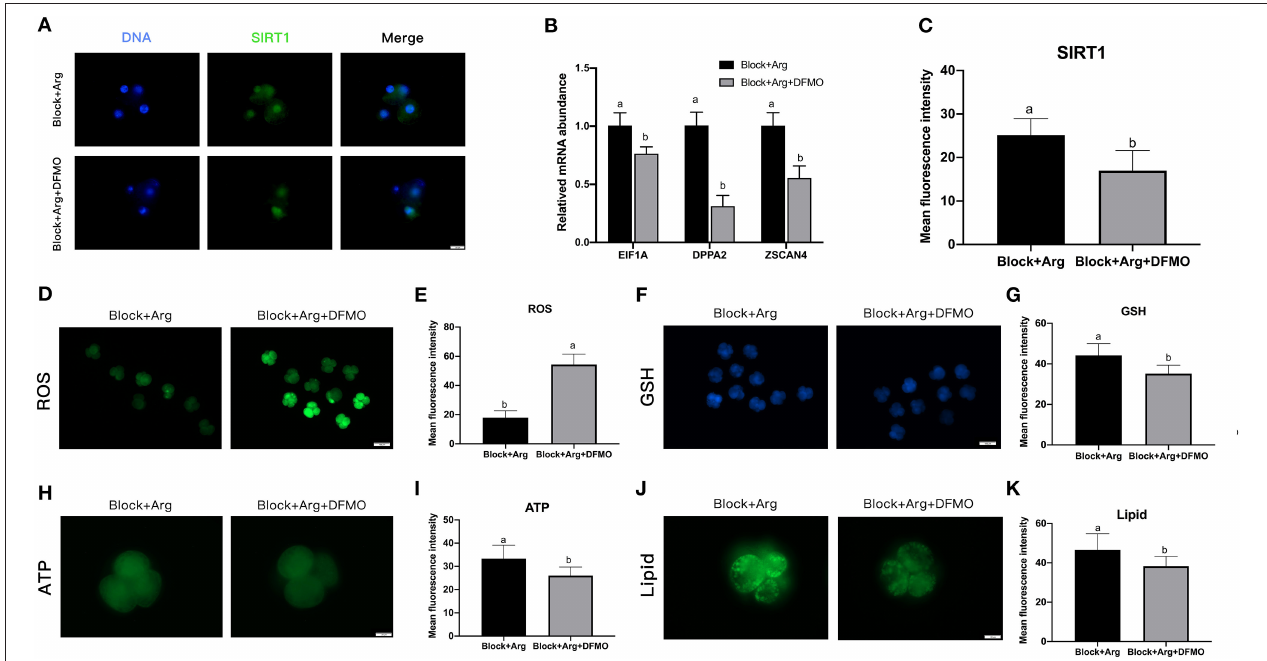
FIGURE 6 | The effect of arginine on ZGA via ODC1 under nutrition restriction. (A) Representative fluorescence images of SIRT1 in the Block + Arg and Block + Arg + DFMO groups. Bar = 50 µ m. (B) Expression of ZGA genes measured by qRT-PCR in the Block + Arg and Block + Arg + DFMO groups. n = 3; different letters (a, b) indicate significant differences ( P = 0.05). (C) Results of the statistical analysis of whole-cell SIRT1 intensity in the Block + Arg and Block + Arg + DFMO groups. Block + Arg: n = 30; Block + Arg + DFMO: n = 30. (D) The 4-cell embryos were stained with DCFH-DA to measure the ROS levels in the Block + Arg and Block + Arg + DFMO groups. Bar = 100 µ m. (E) Results of the statistical analysis of embryonic ROS intensity in the Block + Arg and Block + Arg + DFMO groups. Block + Arg: n = 30; Block + Arg + DFMO: n = 30. (F) The 4-cell embryos were stained with Cell Tracker Blue to measure the GSH levels in the the Block + Arg and Block + Arg + DFMO groups. Bar = 100 µ m. (G) Results of the statistical analysis of embryonic GSH intensity in the Block + Arg and Block + Arg + DFMO groups. Block + Arg: n = 30; Block + Arg + DFMO: n = 30. (H) The 4-cell embryos were stained with BODIPY-ATP to measure the ATP levels in the Block + Arg and Block + Arg + DFMO groups. Bar = 50 µ m. (I) Results of the statistical analysis of embryonic ATP intensity in the Block + Arg and Block + Arg + DFMO groups. Block + Arg: n = 30; Block + Arg + DFMO: n = 30. (J) The 4-cell embryos were stained with the lipophilic dye BODIPY 493/503 to measure Lipid droplets in the Block + Arg and Block + Arg + DFMO groups. Bar = 50 µ m. (K) Results of the statistical analysis of embryonic Lipid droplets intensity in the Block + Arg and Block + Arg + DFMO groups. Block + Arg: n = 30; Block + Arg + DFMO: n = 30. Different letters denote significant difference ( P <